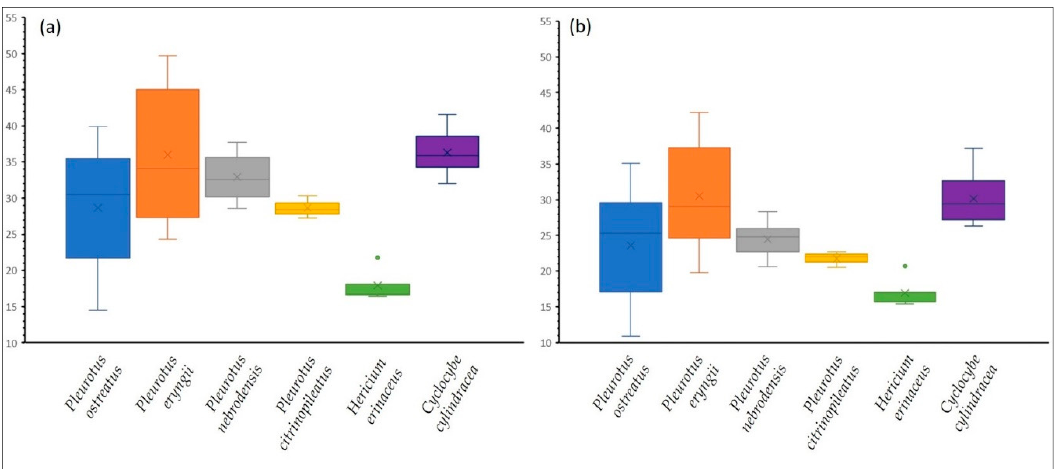
Figure 1. Box plots depicting ( a ) total and ( b ) β -glucan content (%, dry weight [d.w.]) of mushroom species cultivated in various substrates. The horizontal line in each box represents the median, the x represents the mean, the rectangle represents the second and third quartile. An outlier (green dot) is shown among Hericium erinaceus cases.